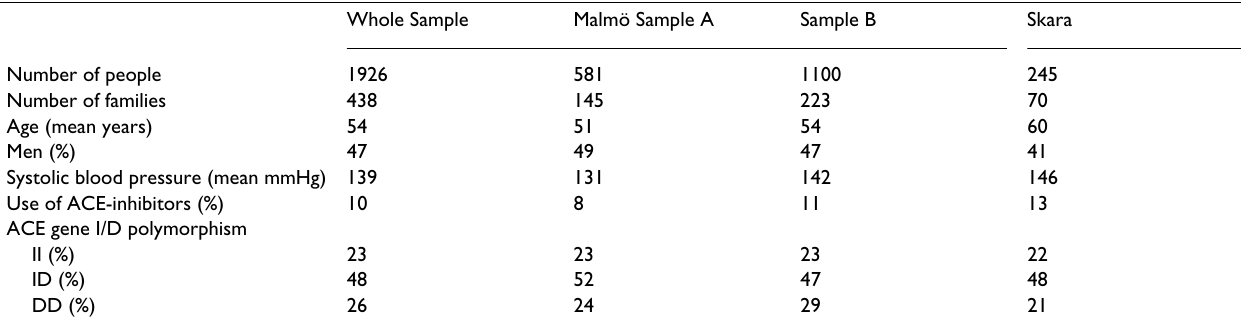
Table 1: Characteristics of the 1926 individuals from 438 Swedish families with history of